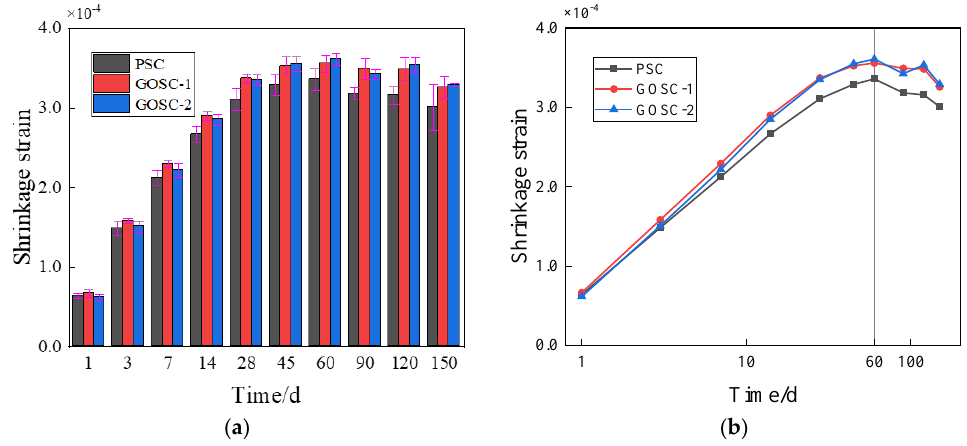
Figure 4. Changes of the shrinkage strain of concrete with time. ( a ) Variability of shrinkage; ( b ) trend graphic in which the age of the concrete uses a logarithmic scale.